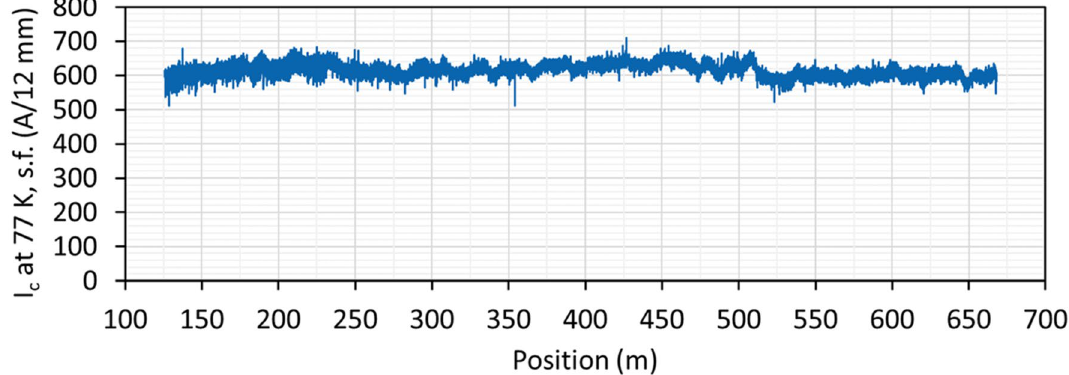
Figure 7. Typical data on critical current at 77 K in self-field along the length of a 542 m long, 12 mm wide YBCO-based 2G HTS wire, serial number 1034 (126–668). Average critical current is 618 ± 18